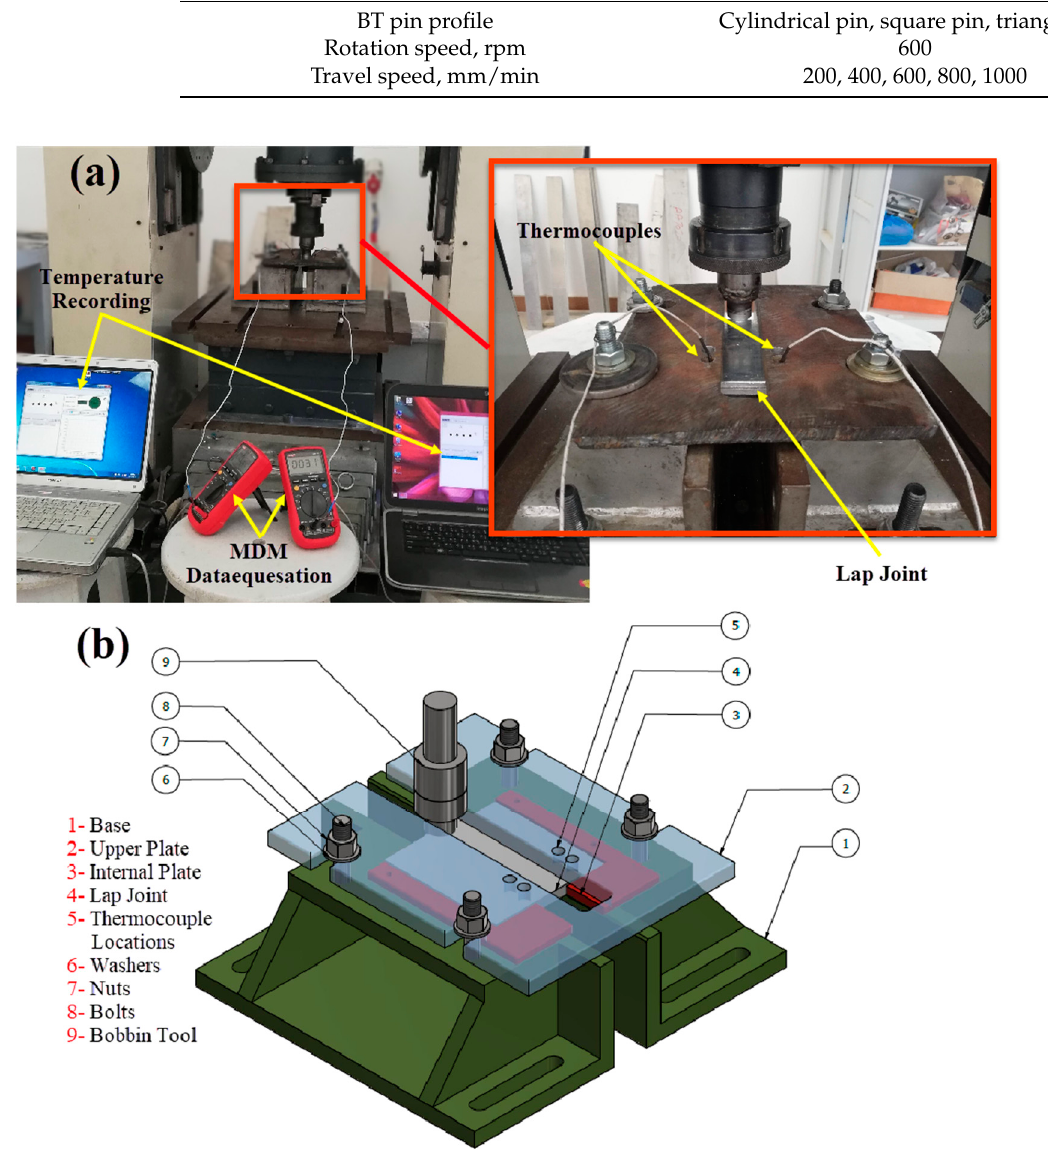
Figure 3. BT-FSW fixture setup configuration to weld AA1050-H14 in similar lap joints at the different welding parameters. ( a ) overview the BT-FSW using this fixture and ( b ) the 3D drawing with identification of all components.